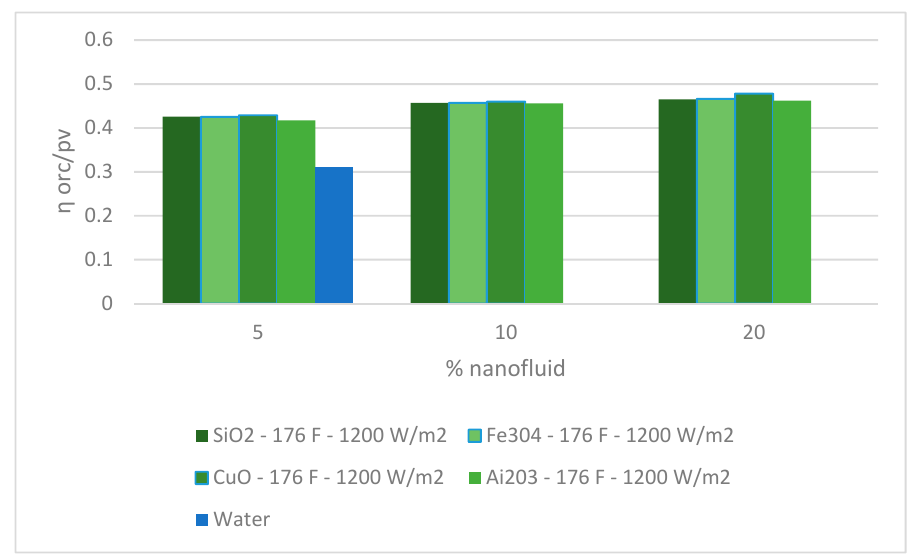
Figure 16. Hybrid system e ffi ciency for di ff erent nanofluids at 176 ◦ F